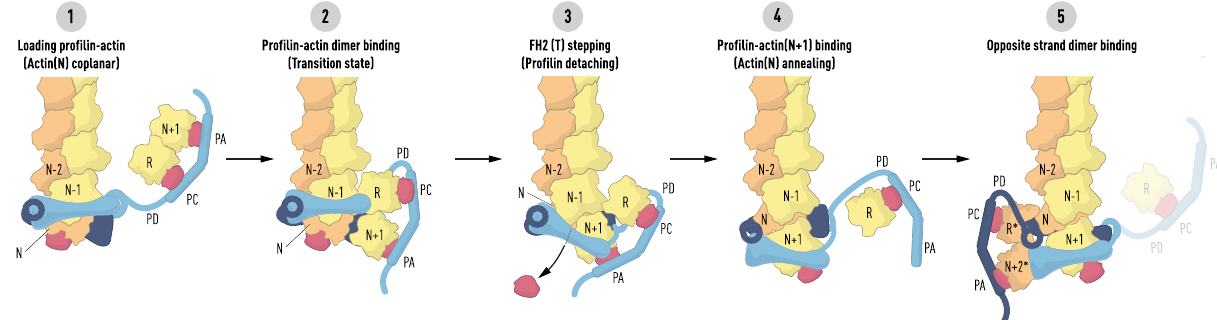
Figure 6. Schematic of the formin elongation reaction. Panel 1 represents the state of the actin polymerase after the insertion of actin(N) in a coplanar orientation with actin(N−2) on the same strand (orange). Its associated profilin (red) is held in place by its interaction with actin(N) and FH2(L). The actin(R)-actin(N+1) dimer has bound FH1 via the affinity of their profilin molecules for poly-l-proline tracts (PC and PA). Panel 2 depicts the binding of actin(R) to actin(N−1) which places actin(N+1) at the entrance to its binding pocket. Panel 3 shows the second stepping event where the dissociation of FH2(T) and its migration towards the barbed end ferries its linker-lasso (light blue) towards the post of FH2(L) as profilin is released from actin(N). The bond between actin(R) and actin(N−1) is broken as actin(N+1) is drawn into the pocket formed by the knob of FH2(T) and the post of FH2(L). Panel 4 represents the state where actin(N) has rotated and docked into the helical niche formed by actin(N−1) and actin(N−2). Actin(N−1) and actin(N+1) are coplanar, actin(R) has been carried off by FH1 and the FH2(T) lasso has bound to the FH2(L) post. Panel 5 illustrates step 2 in the recruitment of N+2 on the opposite strand (orange, marked *) of the actin filament after actin(R*) has bound to the (now) penultimate subunit actin(N). The FH2(T) linker-lasso and FH1 are in dark